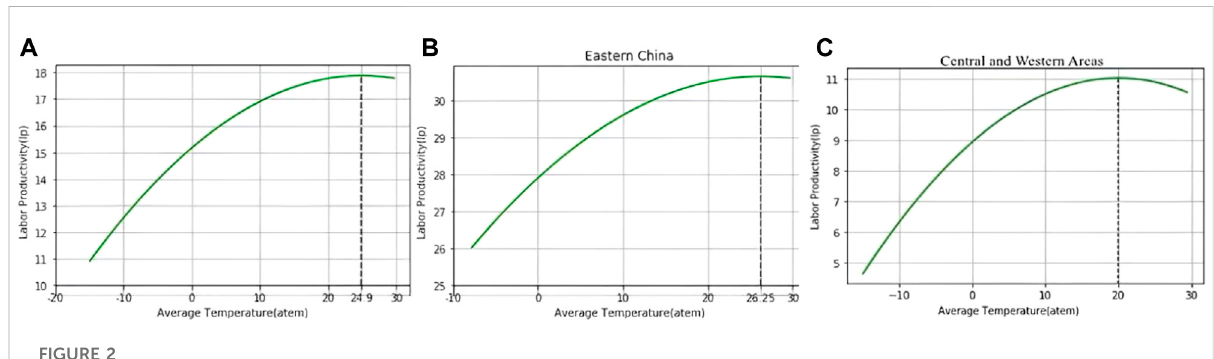
FIGURE 2 Therelationshipbetweenestimatedconstructionlaborproductivityandtemperatureofallareas (A) ,EasternChina (B) ,andCentralandWestern China (C) .